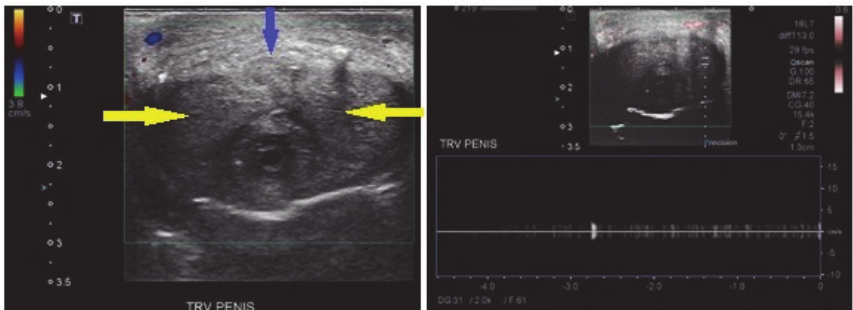
Figure 2: Penile ultrasound Doppler showing no demonstrable arterial flow within the heavily calcified penile arteries (yellow: cavernosal; blue: dorsal).